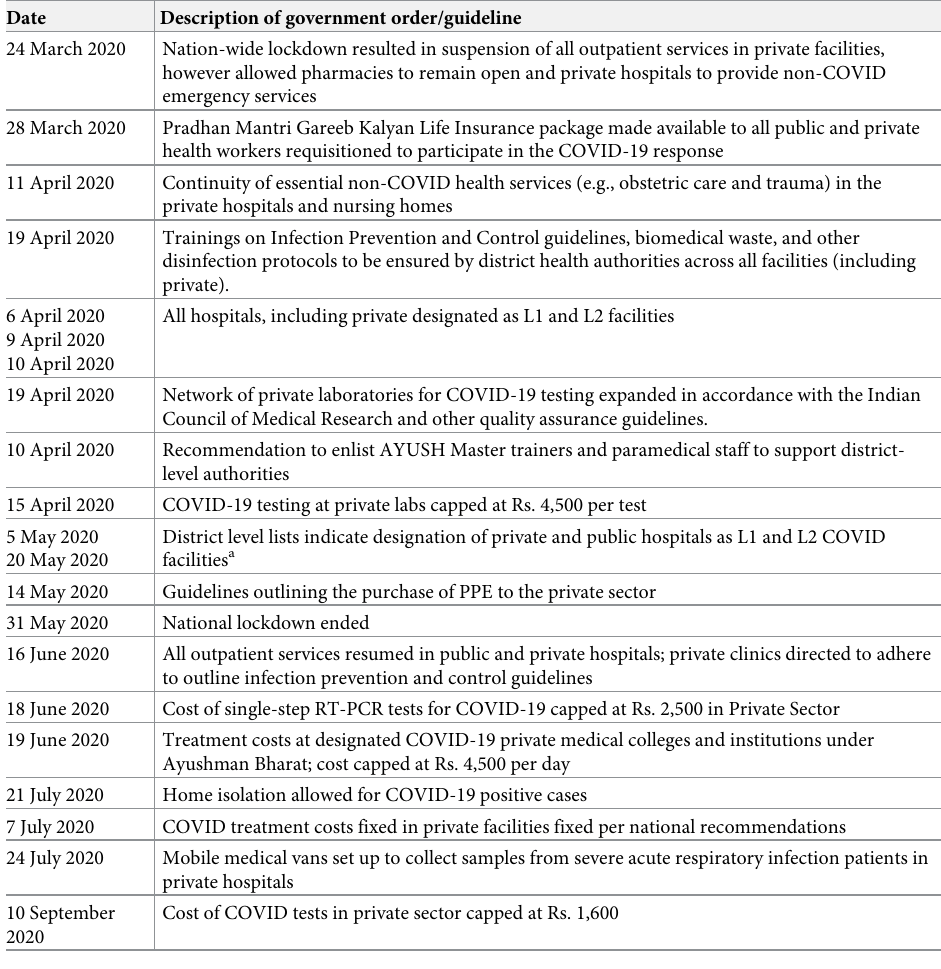
Table 3. Timeline showing key policy measures highlighting the role of the private sector during